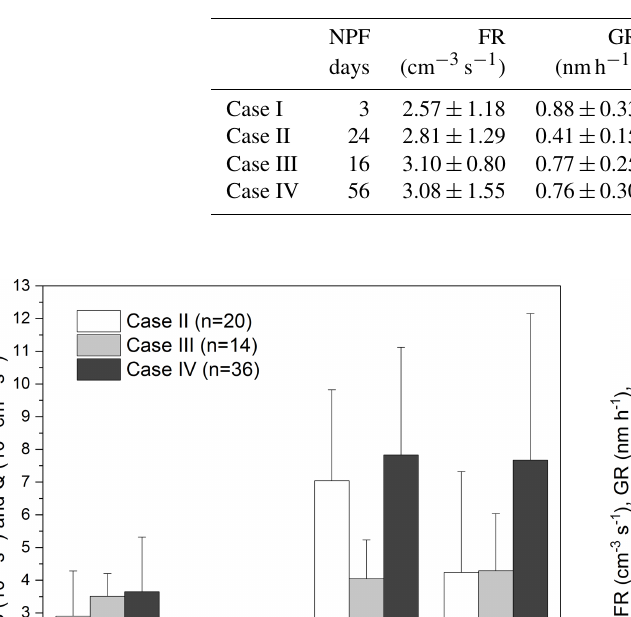
Table 5. Summary of NPF characteristic statistics depending on the air mass origin. FR is the formation rate, GR is the growth rate, CS is the condensation sink and Q is the source rate of condensable vapor. Case I, Case II, Case III and Case IV refer to the origin and pathway of air masses from South America, the Weddell Sea, the Antarctic Peninsula and the Bellingshausen Sea, respectively.